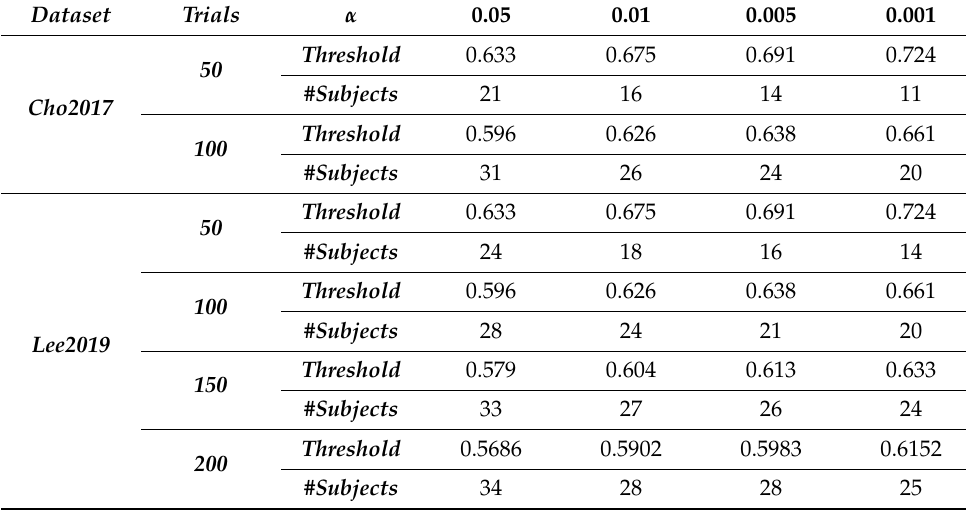
Table 1. Selective subject pool created using two MI BCI